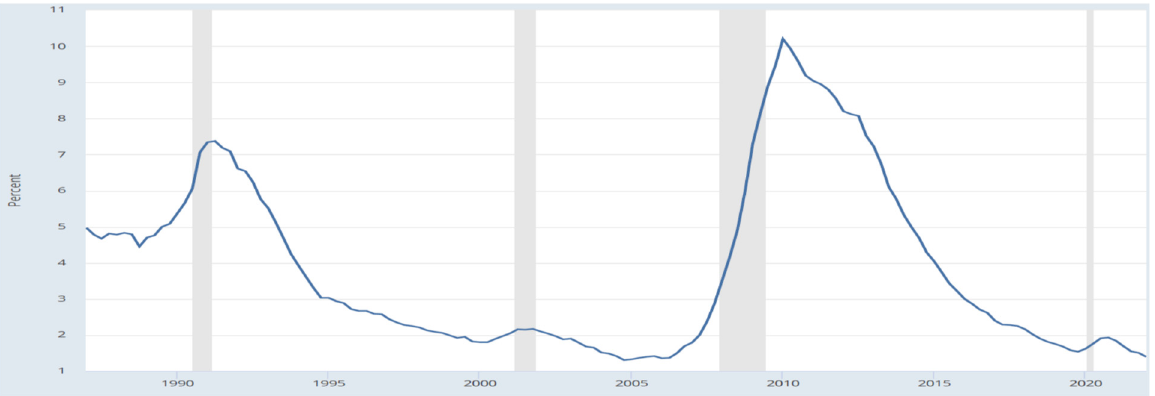
Figure 5. Delinquency Rate on Loans Secured by Real Estate, All Commercial Banks. Source: Board of Governors of the Federal Reserve.